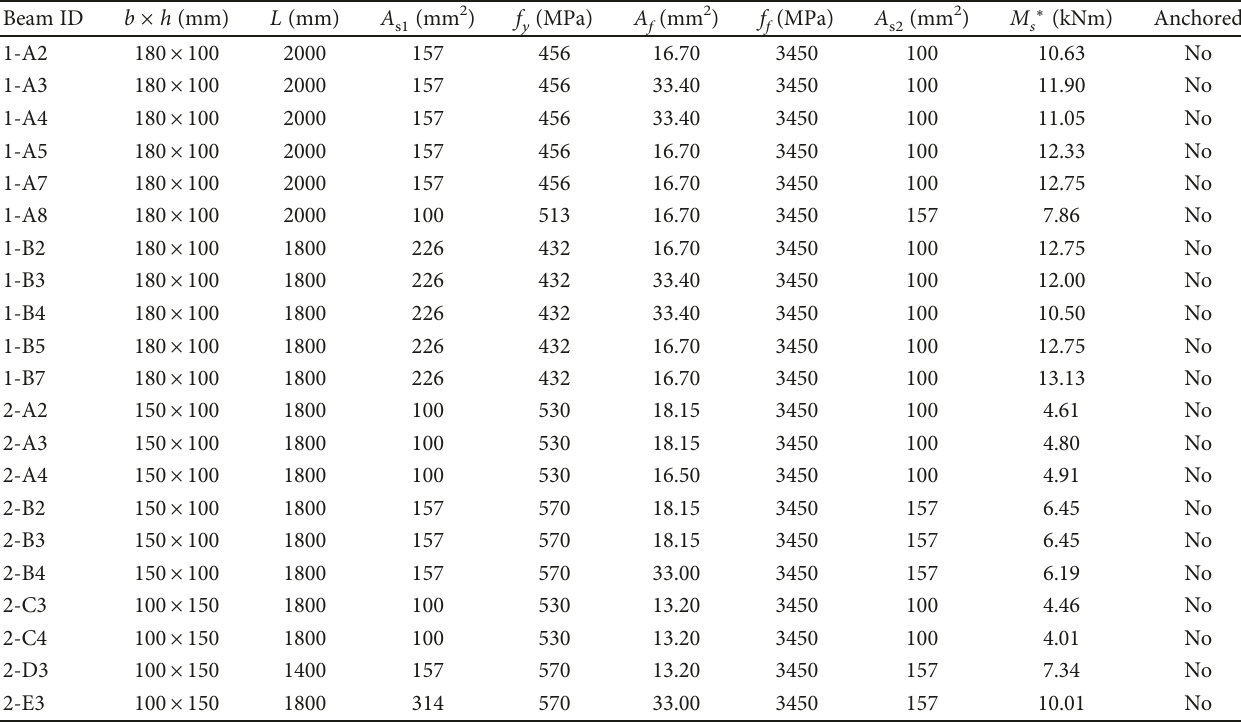
Table 2: Properties of additional beams for serviceability stage